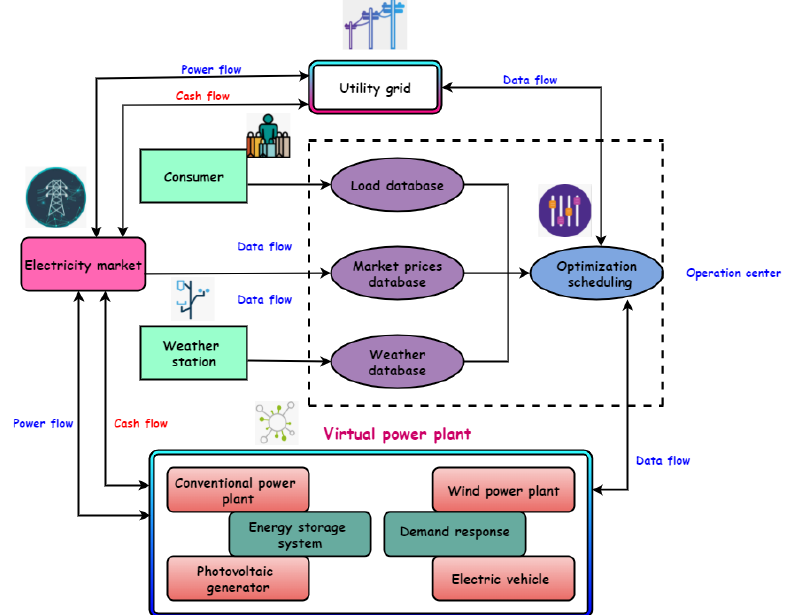
Figure 2. A framework for developing a virtual power plant (VPP).